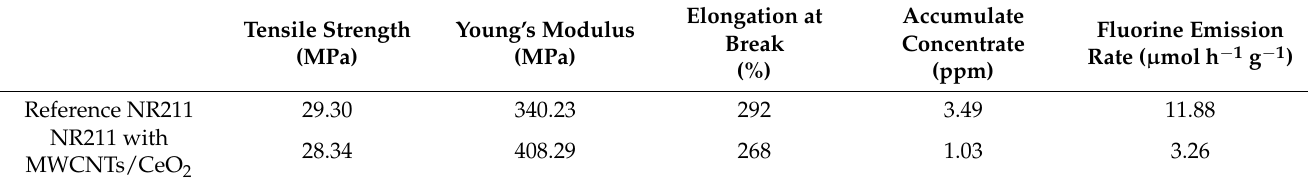
Table 2. Summary of the stress–strain curves and Fenton’s